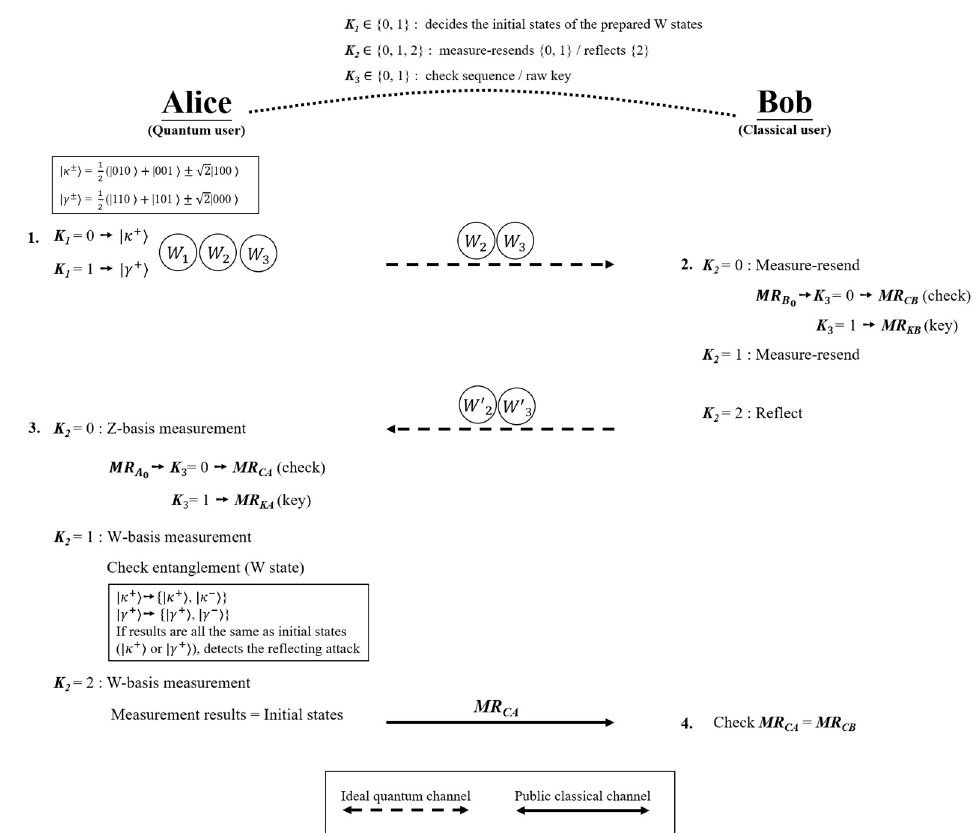
Figure 1. Proposed ASQKD protocol.